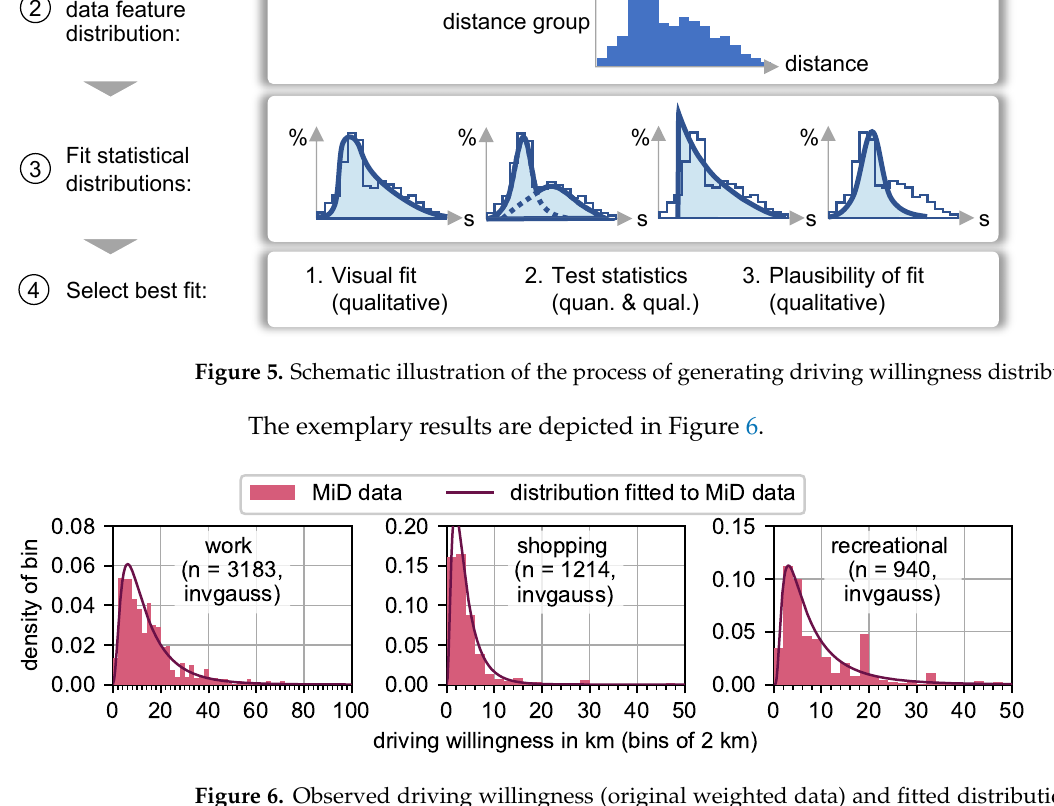
Figure 6. Observed driving willingness (original weighted data) and fitted distributions with the best